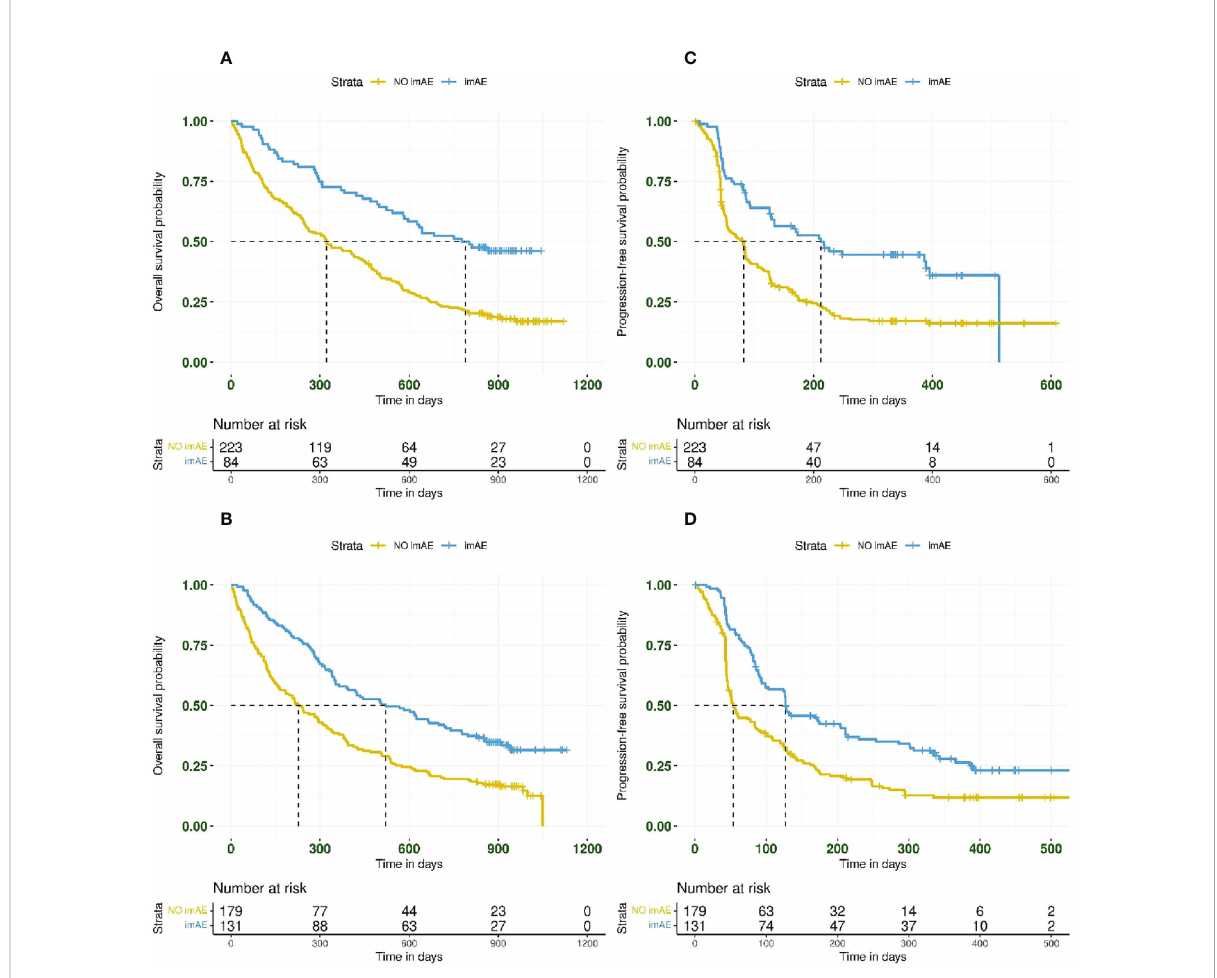
FIGURE 2 Kaplan – Meier plots for overall survival and progression-free survival based on imAE development in the durvalumab arm (panels A , C for OS and PFS, respectively) and the durvalumab plus tremelimumab arm (panels B , D for OS and PFS, respectively). imAE, immune-mediated adverse event; OS, overall survival; PFS, progression-free